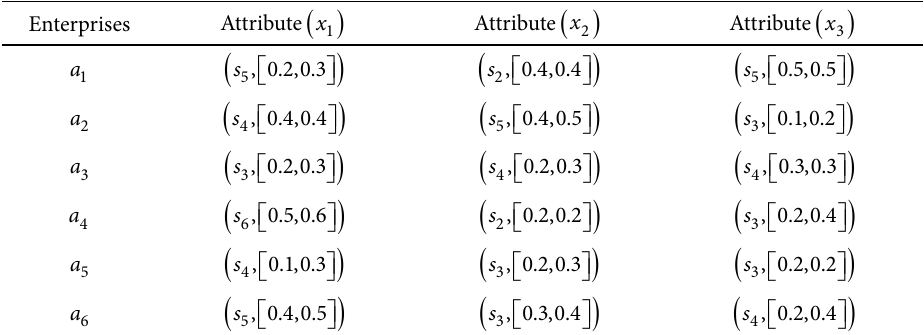
Table 1. The attribute values of each attribute with respect to six enterprises given by experts